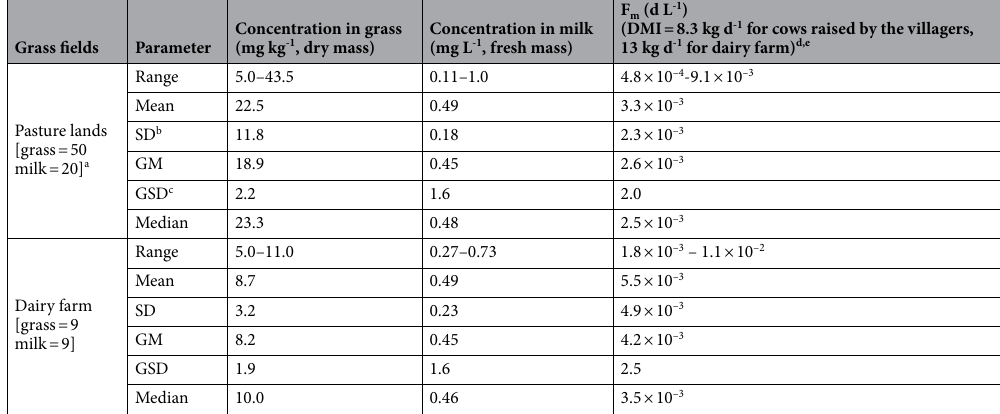
Table 5. Stable Sr concentration in pasture land grass and milk of cows raised by the villagers and corresponding F m values. a Values within the square bracket represents samples analyzed. b SD represents standard deviation. c GSD represents the geometric standard deviation (unitless). d DMI by cows raised by the villagers is 8.3 kg d -1 of grass (no supplement diet); for the dairy farm, it is 4.4 kg d -1 of grass + 8.6 kg d -1 of nutrient supplement diet. e Sr concentration in the supplement feed was below the detection limit.